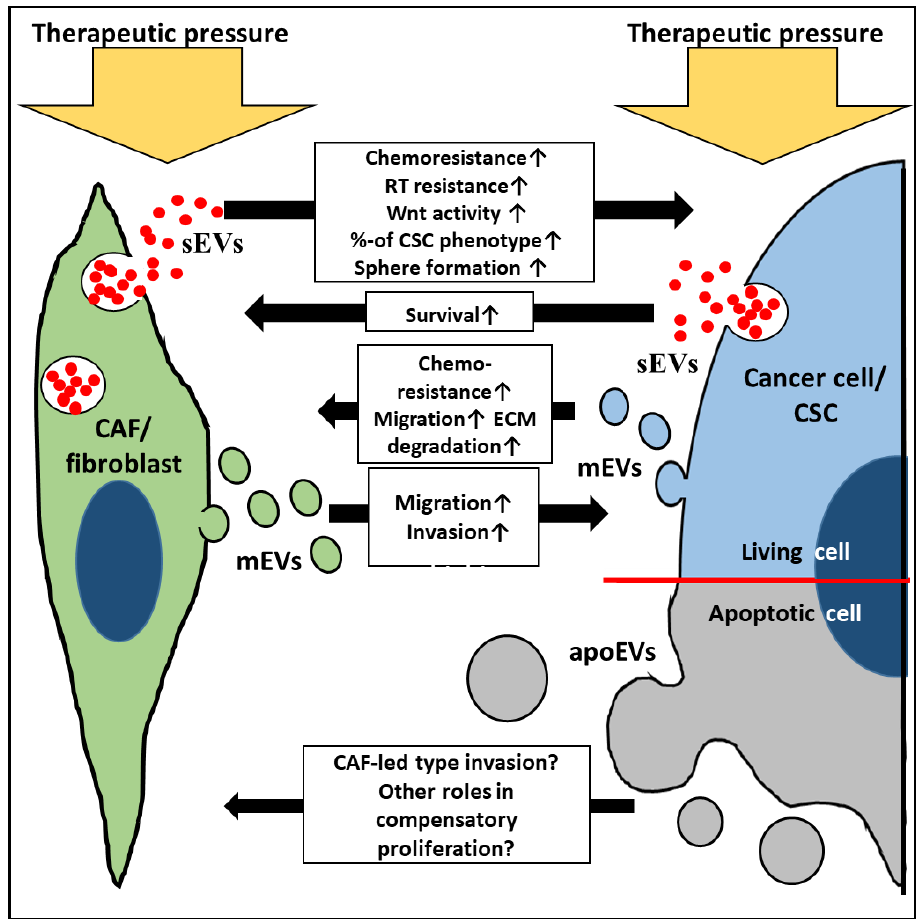
Figure 2. Simplified illustration of EV-based communication between therapeutic pressured fibroblasts / CAFs (green) and cancer cells / CSCs (blue and grey). apoEVs: apoptotic cell-derived EVs (grey circles); CSC: cancer stem cell; ECM: extracellular matrix; mEVs: medium-sized EVs (green circles: CAF / fibroblast origin, blue: cancer cell origin); RT: radiation therapy; sEVs: small EVs.